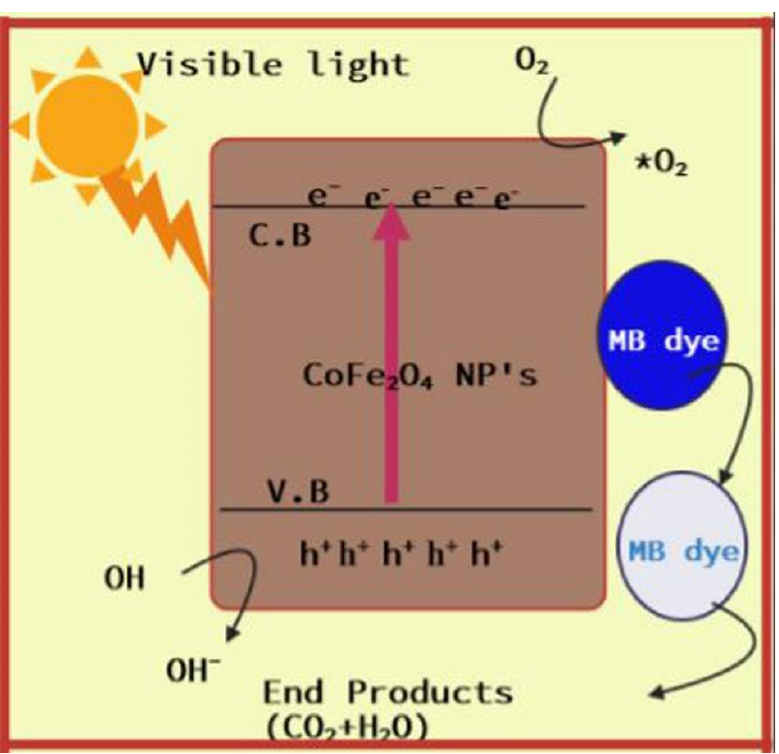
Figure 9. Photocatalytic dye degradation mechanism of biosynthesized CoFe 2 O 4 nanoparticles.